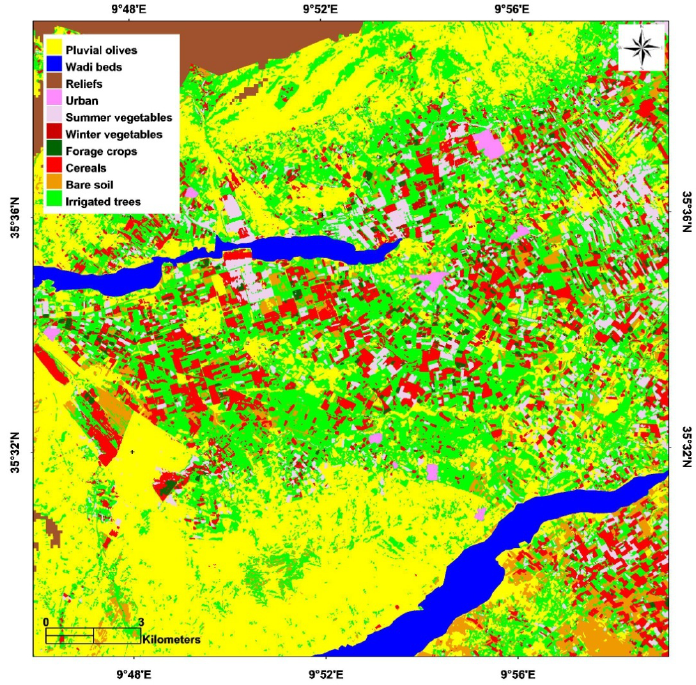
Figure 4. Land use map for the 2010–2011 agricultural season.